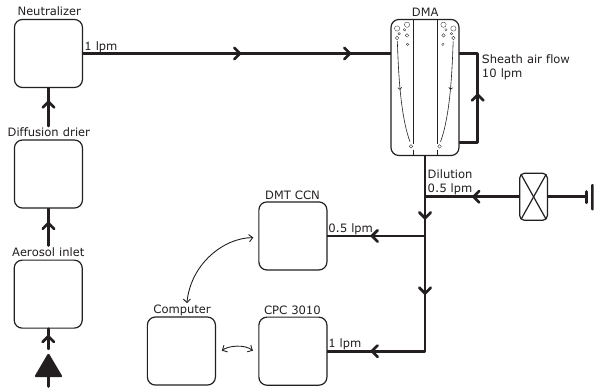
Fig. 1. Sketch of the terrain of the HCCT experiment. For an approaching flow from southwest, Goldlauter is theupwindstationandGehlbergthedownwindstation. Thiswasthecaseforalldefinedfullcloudeventsgiven in Table 1.